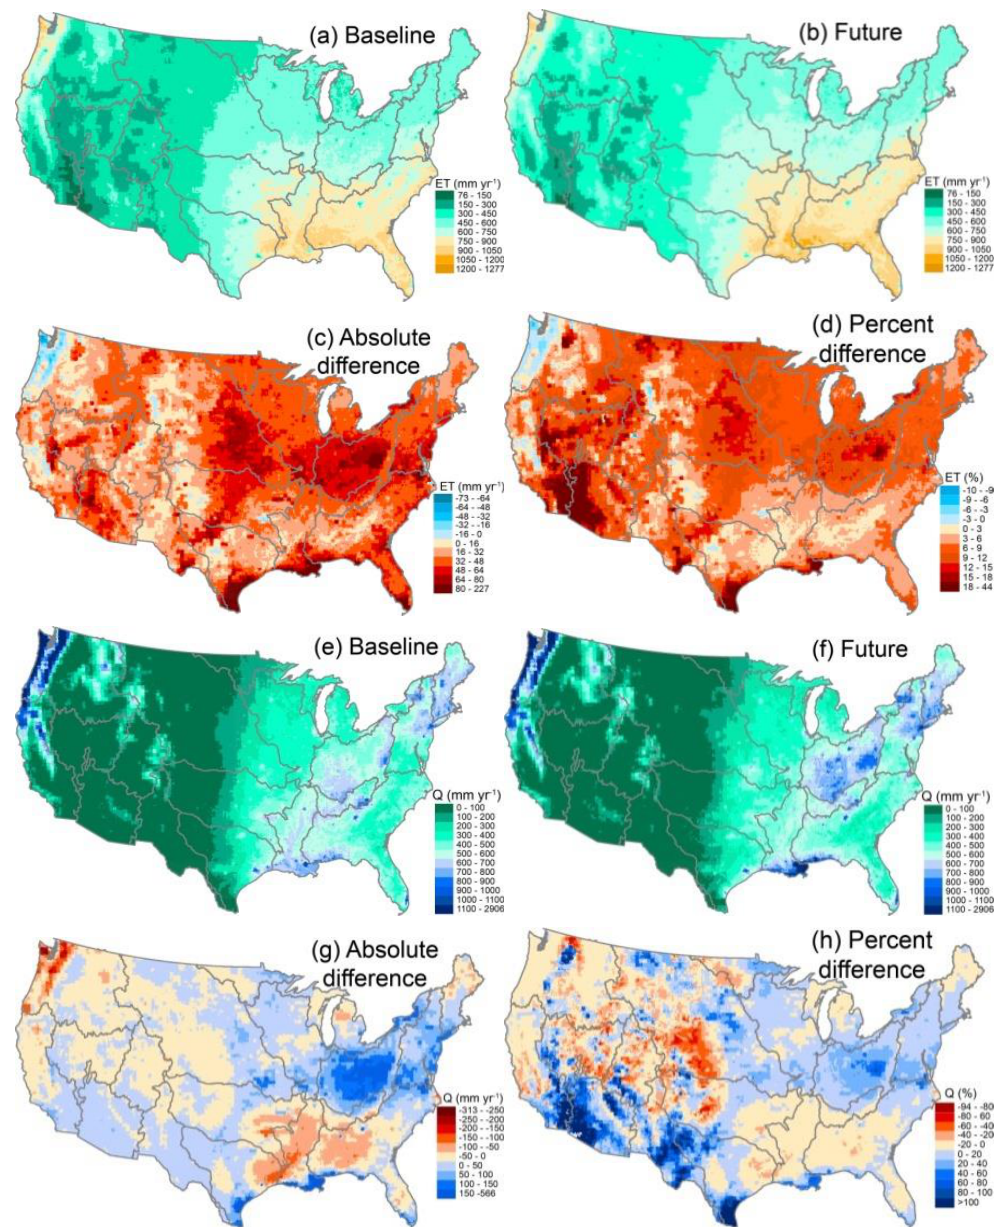
Figure 3. Spatial distribution of ET and Q during the baseline and the future periods, and the future